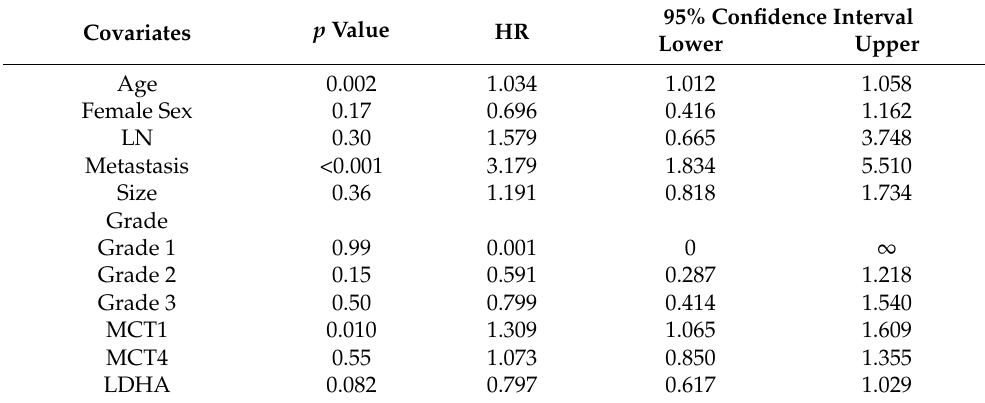
95% Confidence Interval Lower Upper